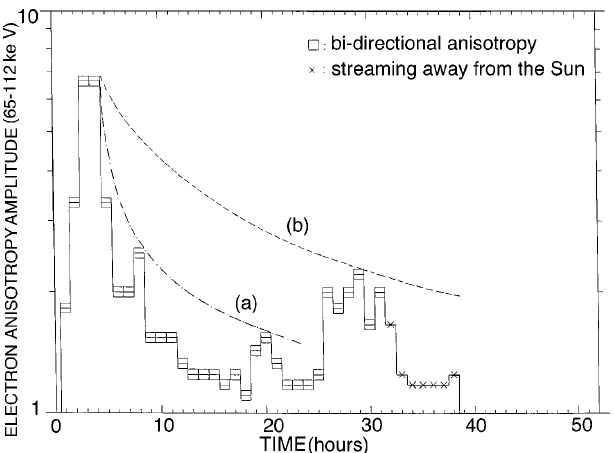
Fig. 3. The absolute magnitude of the 65–112 keV electron anis- otropy ( j / j ) is plotted versus time for the 52 h period from max min entrance of Ulysses in region A till exit from the first ICME. Squares indicate the bi-directional anisotropy value for each hourly-averaged measurement, whereas crosses denote unidirectional anisotropies. Curves a and b form envelopes within which all the values of the electron bi-directional anisotropies for two distinct filaments